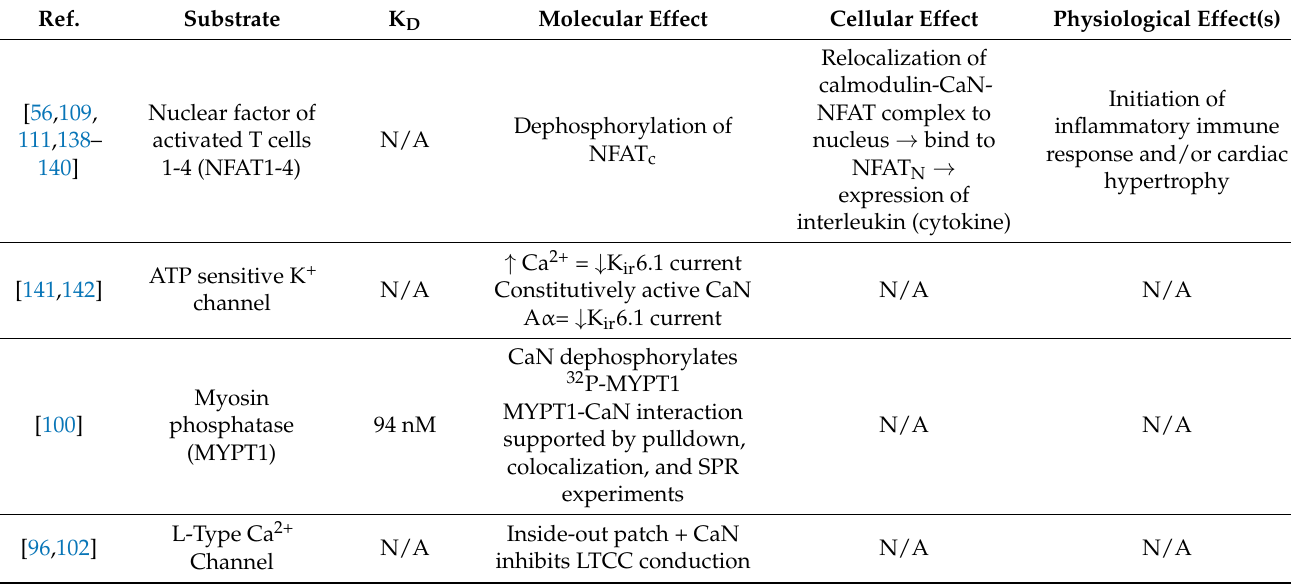
Table 4. List of CaN substrates found in a